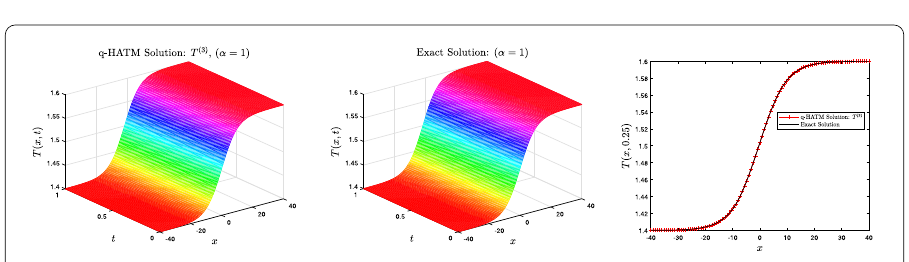
Figure 3 q-HATM vs exact solution when (cid:2) = –1, k = η = 0.1, r = –1.5, p = 1.5, and n = 1 for Example 4.1